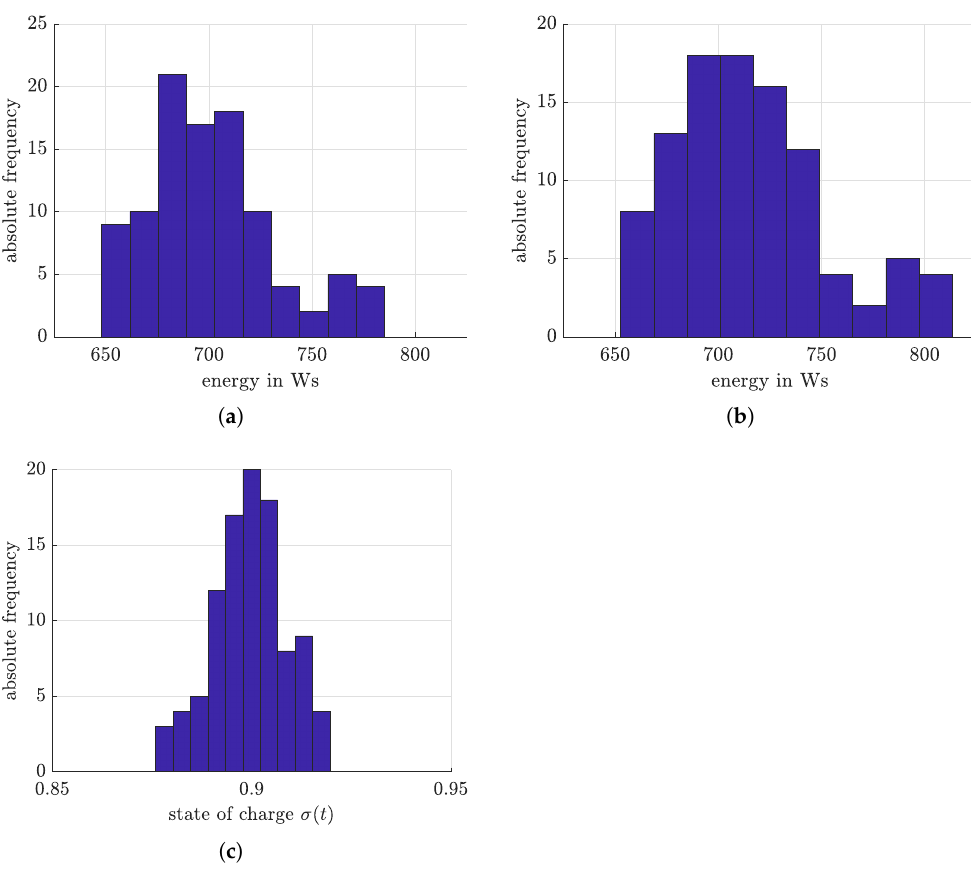
Figure 8. Sensitivity of the Ohmic losses and the terminal SOC for the model predictive control. ( a ) Variability of the Ohmic losses occurring on the time interval t ∈ [ 0 ; 3600 ] s; ( b ) Variability of the Ohmic losses occurring on the time interval t ∈ [ 0 ; 7200 ] s; ( c ) Variability of the SOC at the end of the charging